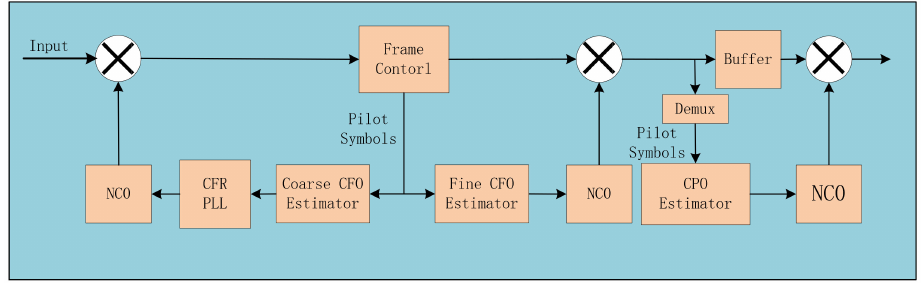
Figure 2. Conventional carrier synchronization scheme.